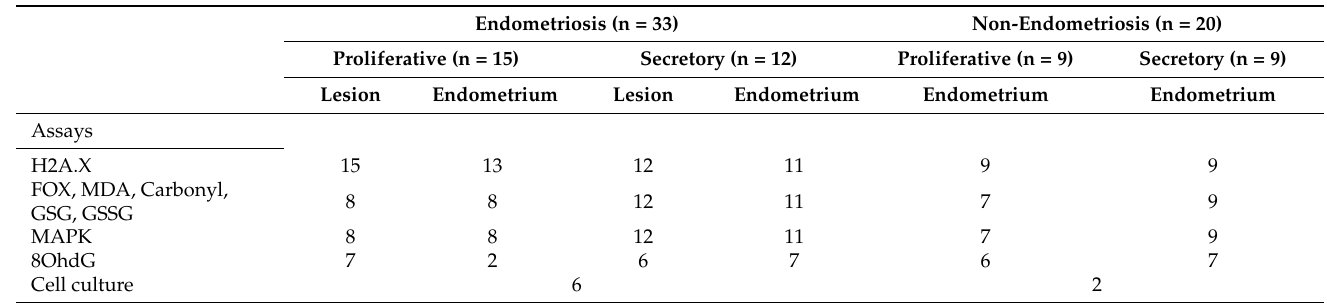
Table 1. Experimental samples, and phases of the menstrual